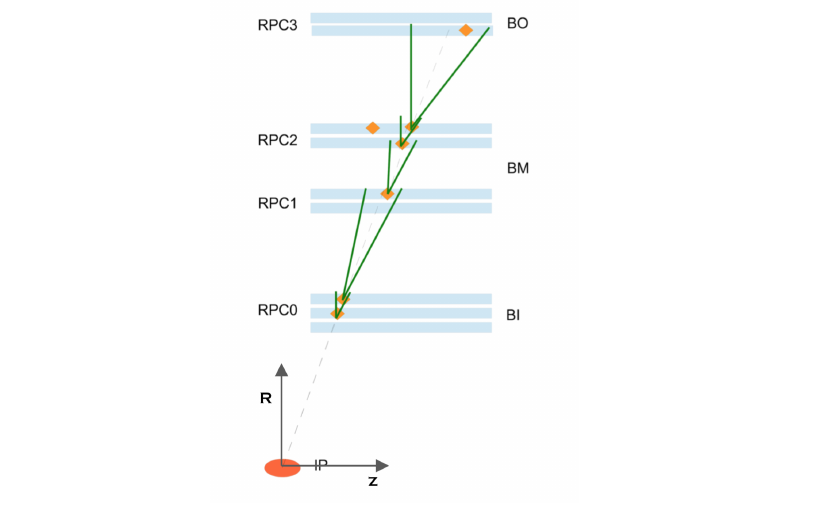
Figure 2. Illustration of the conventional RPC-based trigger algorithm. Hits are linked between con- secutive planes based on predefined coincidence windows centred on a straight-line extrapolation from the nominal interaction point. Patterns of linked hits that satisfy quality requirements are selected as muon track candidates. The width of the coincidence windows defines the p T threshold